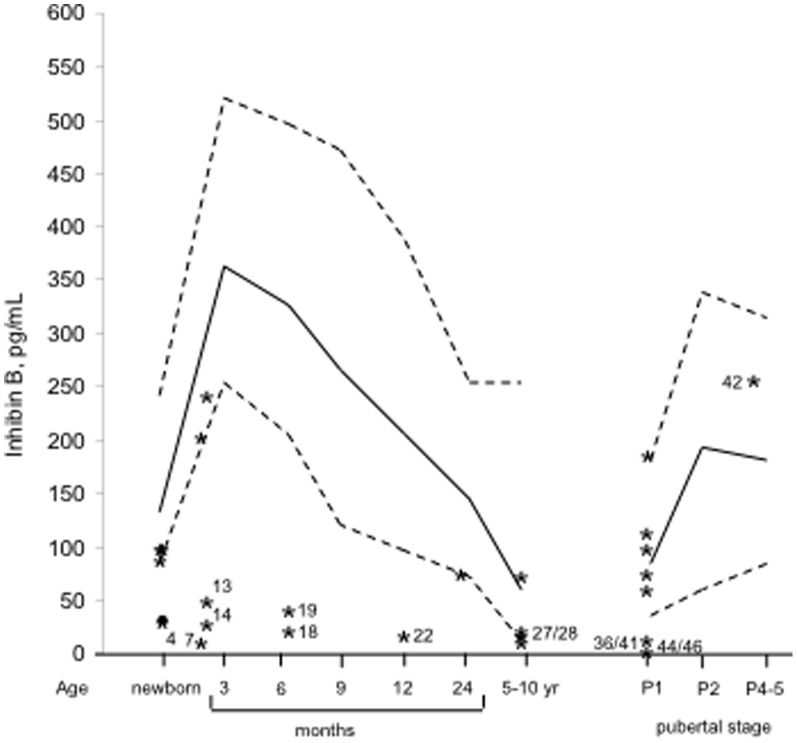
Distribution of the plasma inhibin B concentrations in 27 boys with isolated hypogonadotropic hypogonadism.Solid lines correspond to the median and broken lines to the 5th and 95th percentiles in infants [14] and at each stage of puberty [15]. Numbers (except 42) correspond to low concentrations (Tables 1 and 2): KS in cases 13,41 and 46, CHARGE syndrome in case 27, FGFR1 mutation in cases 14 and 36 and other HH in the others.